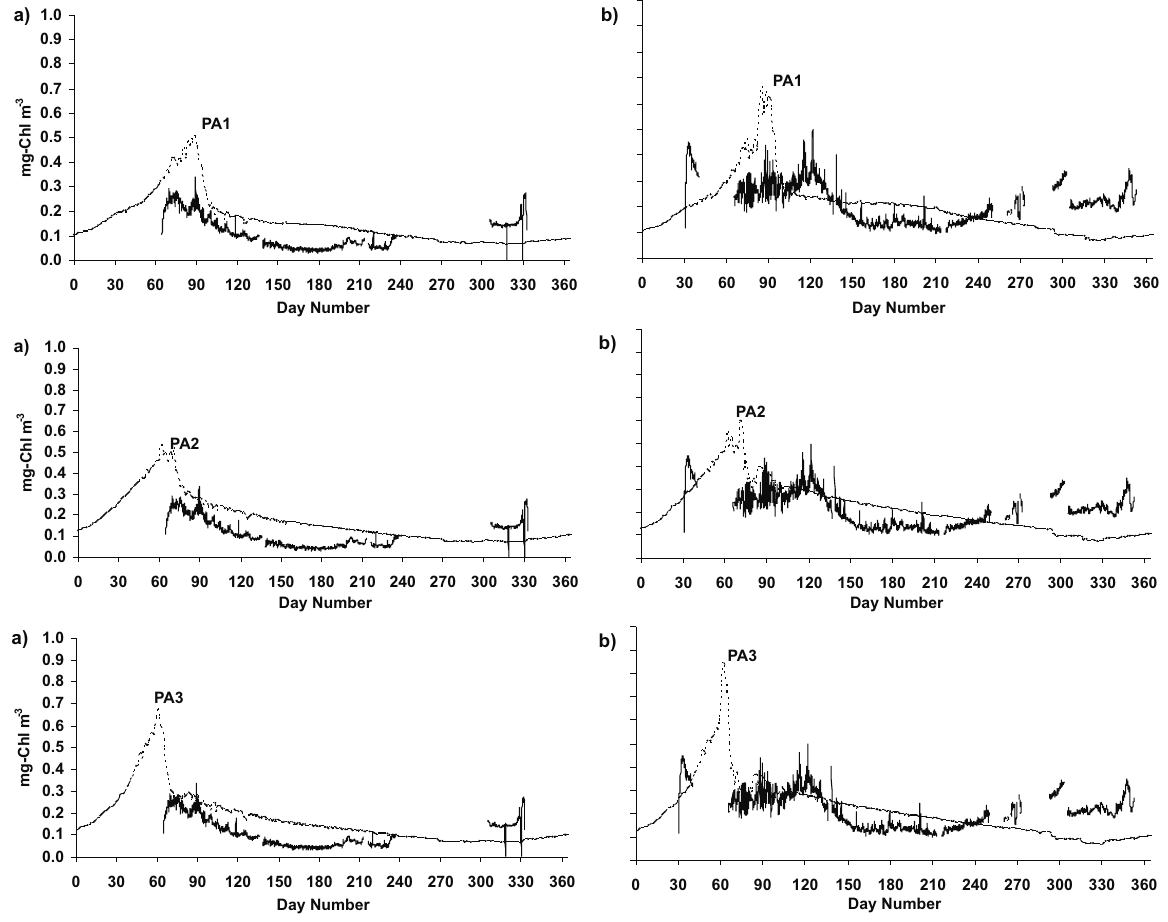
Fig. 5. Comparison of chlorophyll from the model runs PA1 , PA2 and PA3 for (a) 40m depth, (b) 65m depth.